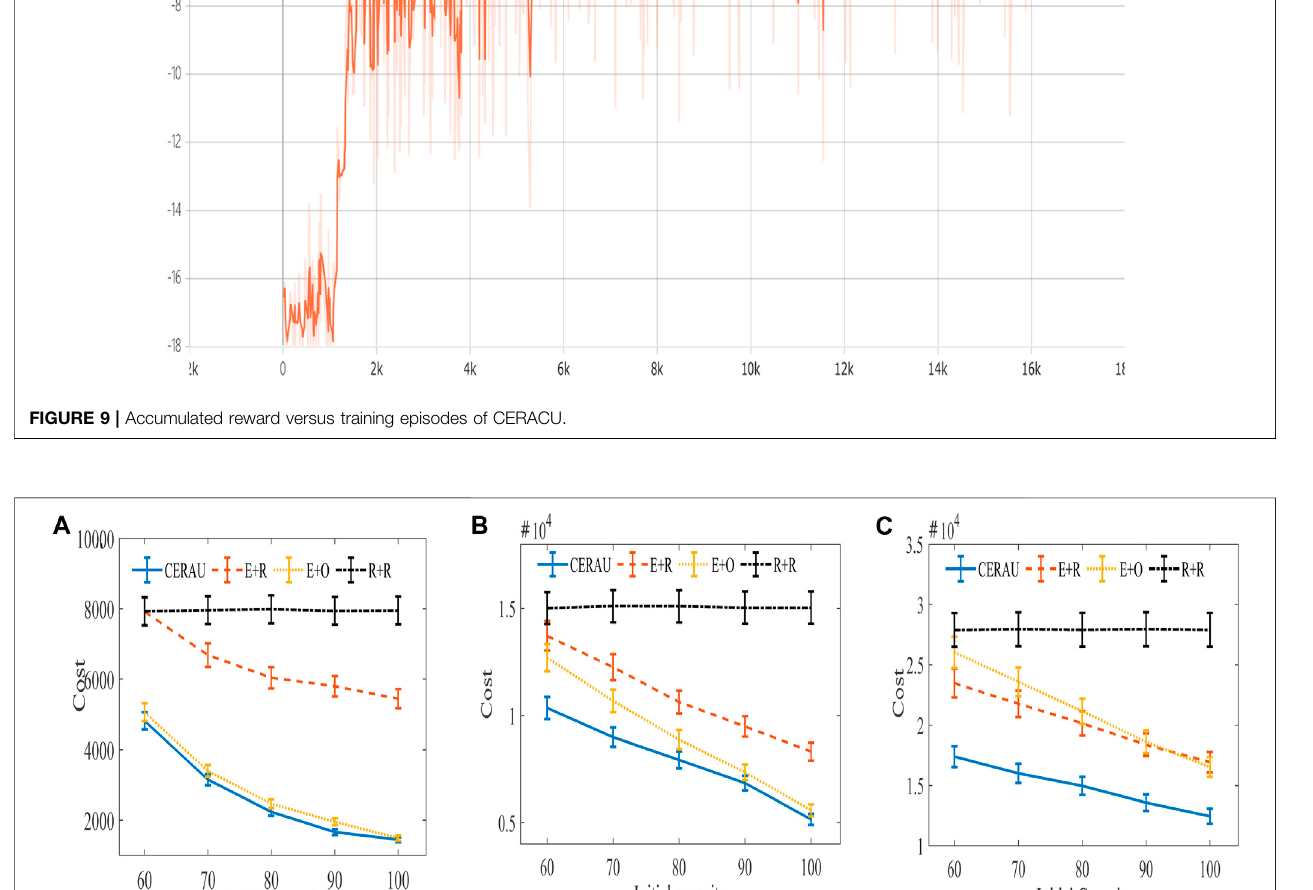
Frontiers in Bioengineering and Biotechnology |